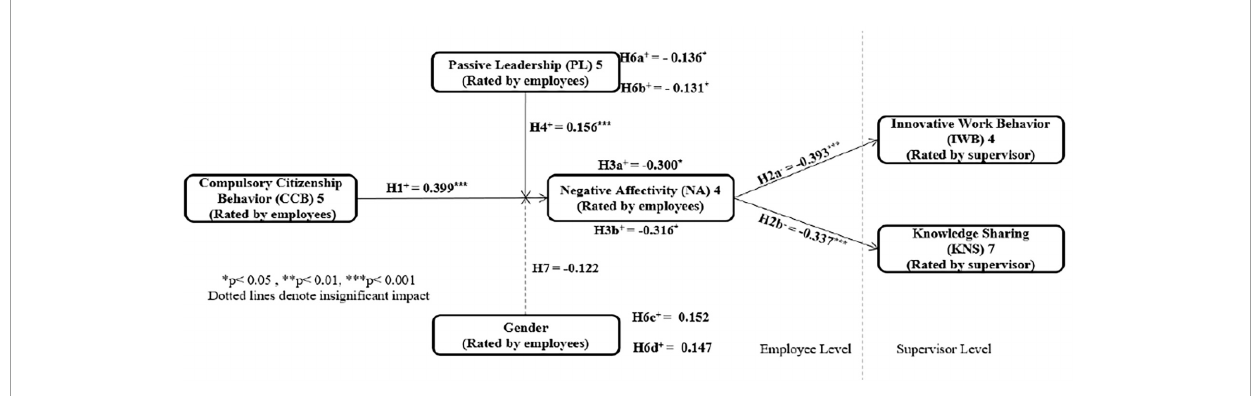
FIGURE3 Model of findings and estimation results. * p < 0.05, ** p < 0.01, and *** p < 0.01. Dotted lines denote insignificant